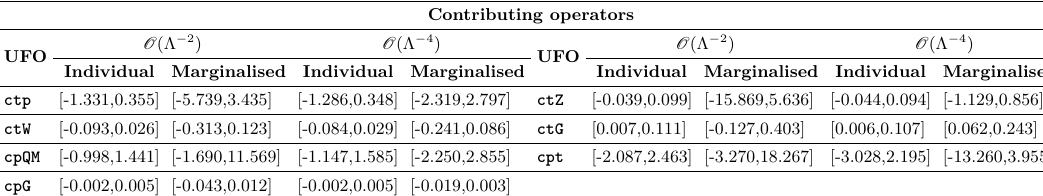
Table 6 . Bounds on four-fermion WCs from the global analysis of ref. [29].